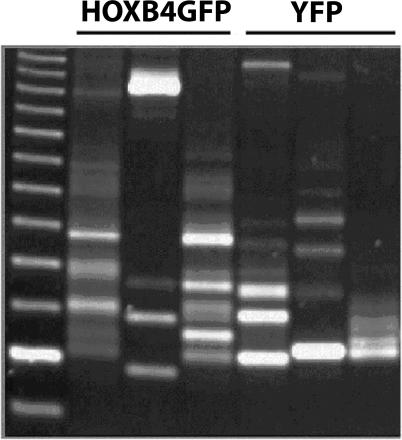
HOXB4-Mediated Expansion Results in Polyclonal RepopulationLAM-PCR was performed on lysates of sorted peripheral blood cells from K03290 at 3 mo post-transplantation. The lane on the far left is a 25-bp DNA ladder. HOXB4GFP indicates a triplicate LAM-PCR analysis for DNA from HOXB4GFP
+ cells. YFP indicates a triplicate LAM-PCR analysis for DNA from YFP
+ cells.